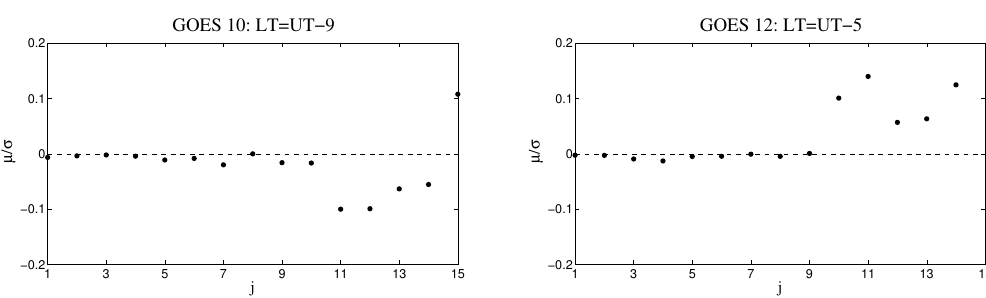
Figure 15. Halloween super storm, 28 October–1 November 2003: SMT applied to the EMD reconstruction of the magnetospheric observa- tions for GOES10 (left panel) and GOES12 (right panel) B z components. The x axis is order in terms of the last mode involved in the partial sums (see Eq. 8).